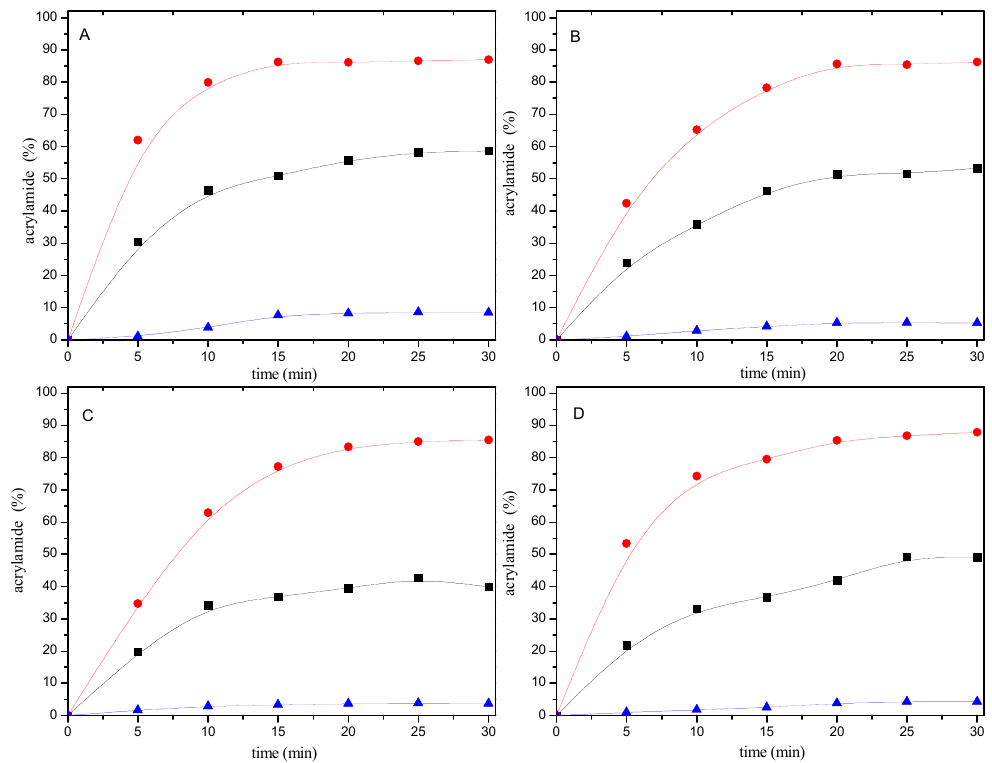
Figure 5. Time-response effect of selected mercaptans ( A ) 1,2-ethanedithiol; ( B ) 2-methyl-3-furanthiol; ( C ) 1-butanethiol; and ( D ) 2-furanmethanethiol on ( ● ), the disappearance of acrylamide in acrylamide/mercaptan reaction mixtures; ( ■ ) the consumption of acrylamide produced to mercaptan-acrylamide adducts; ( ▲ ) the formation of acrylamide from mercaptan-acrylamide adducts. Reaction mixtures containing 0.2 μ mol of either acrylamide or mercaptan-acrylamide adducts and 20 μ mol of the mercaptan were heated at pH 7 and 180 °C for 0–30 min.